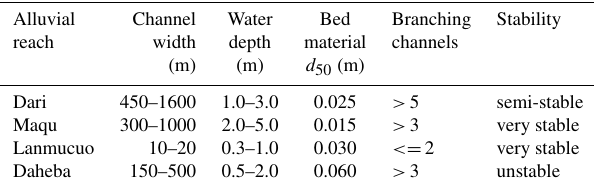
Table 2. Characteristics and bed material of alluvial channels in the four study